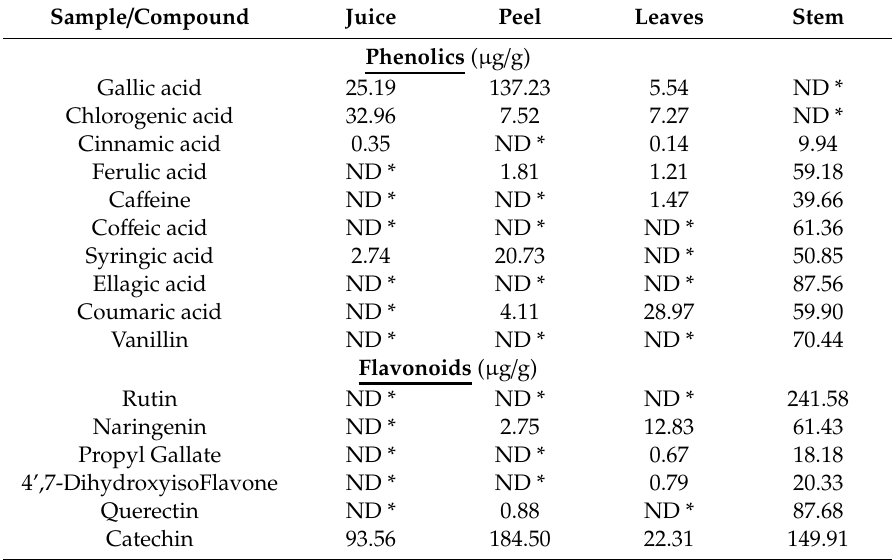
Figure 4. Betaxanthin, betacyanin, and betalain content of beetroot parts (mg / g); (I): IEM; (II): OEM at − 20 ◦ C. Table 2. Phenolic acids and flavonoids identification of beetroot plant